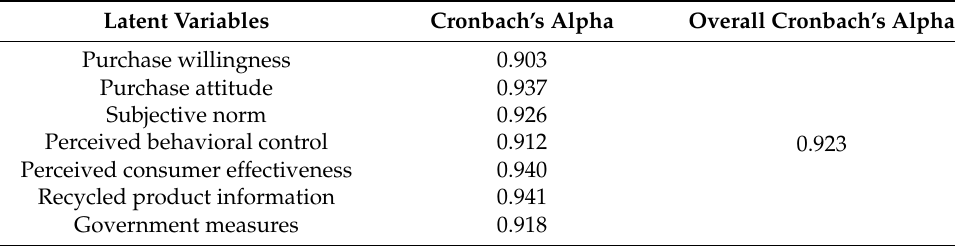
Table 3. Results of the reliability